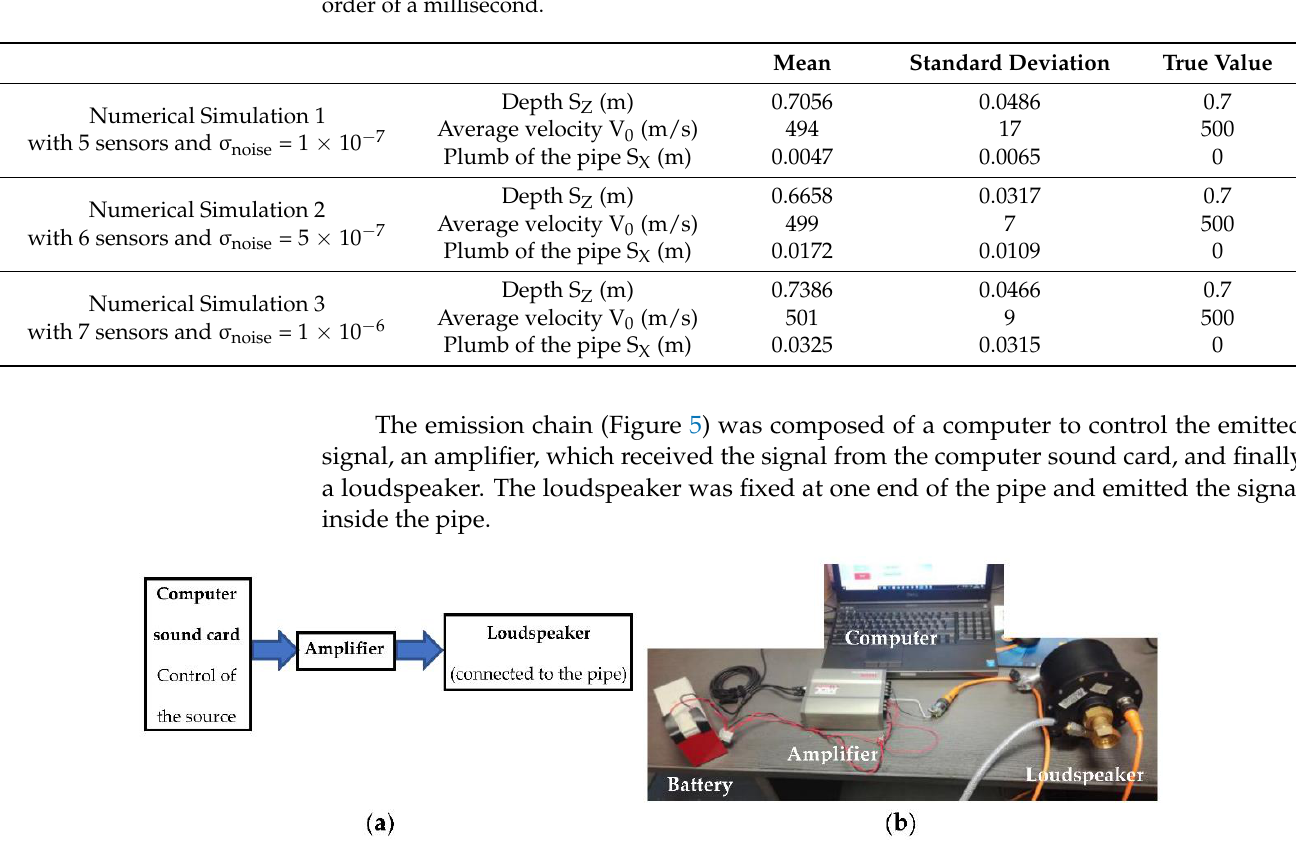
Figure 6. Transfer function of the loudspeaker estimated by emitting a white noise: ( a ) modulus; ( b ) phase.